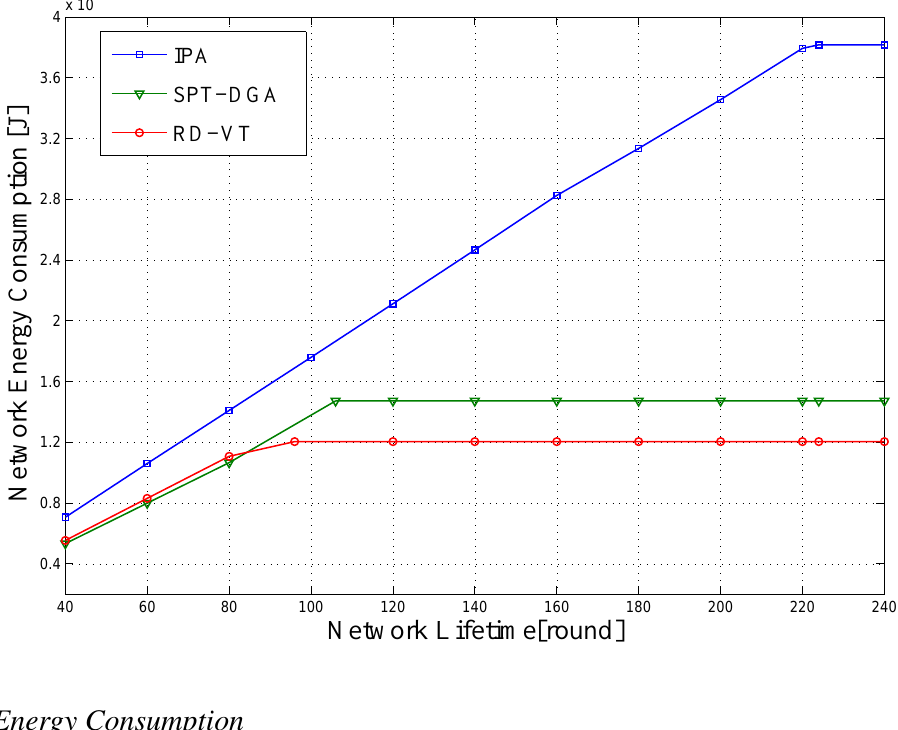
Figure 5. Network energy consumption comparison for three algorithms. The x -axis is the lifetime. IPA reconstructs the shortest path tree and then updates the polling point selection at the end of each round. The y -axis is the accumulation of network energy consumption. The lifetimes of IPA, SPT-DGA and RD-VT are 222 rounds, 104 rounds and 90 rounds,